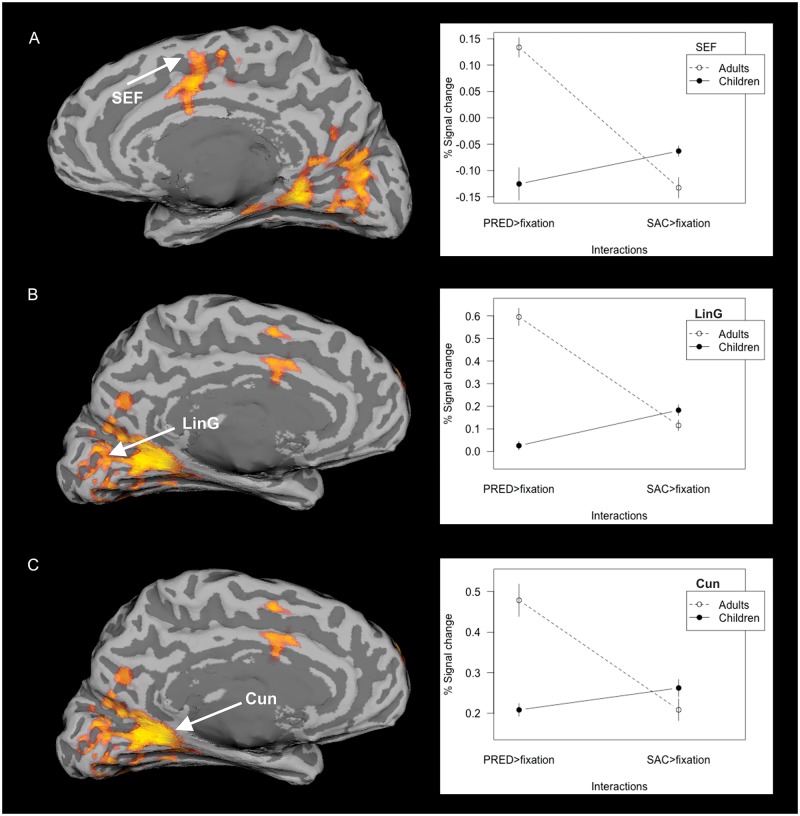
Activated regions in task × group interaction and the average signal variation.The between-group interaction contrast (on the left) in PRED × SAC task with activation in (A) frontal eye field, (B) lingual gyrus, (C) cuneus. Statistical images were thresholded using cluster determined by Z-score > 1.96 and corrected cluster significance threshold of p < 0.05. The average signal change (on the right) plotted for groups of adults and children. (Acronyms: FEF–frontal eye field; LinG–lingual gyrus; Cun–cuneus).